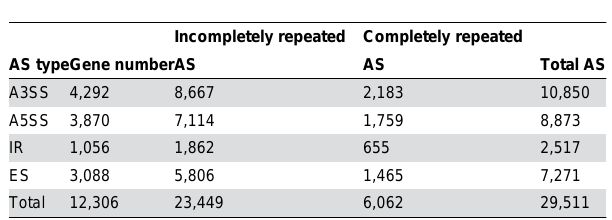
Table 6. A summary of common differences of every AS type between the two samples.